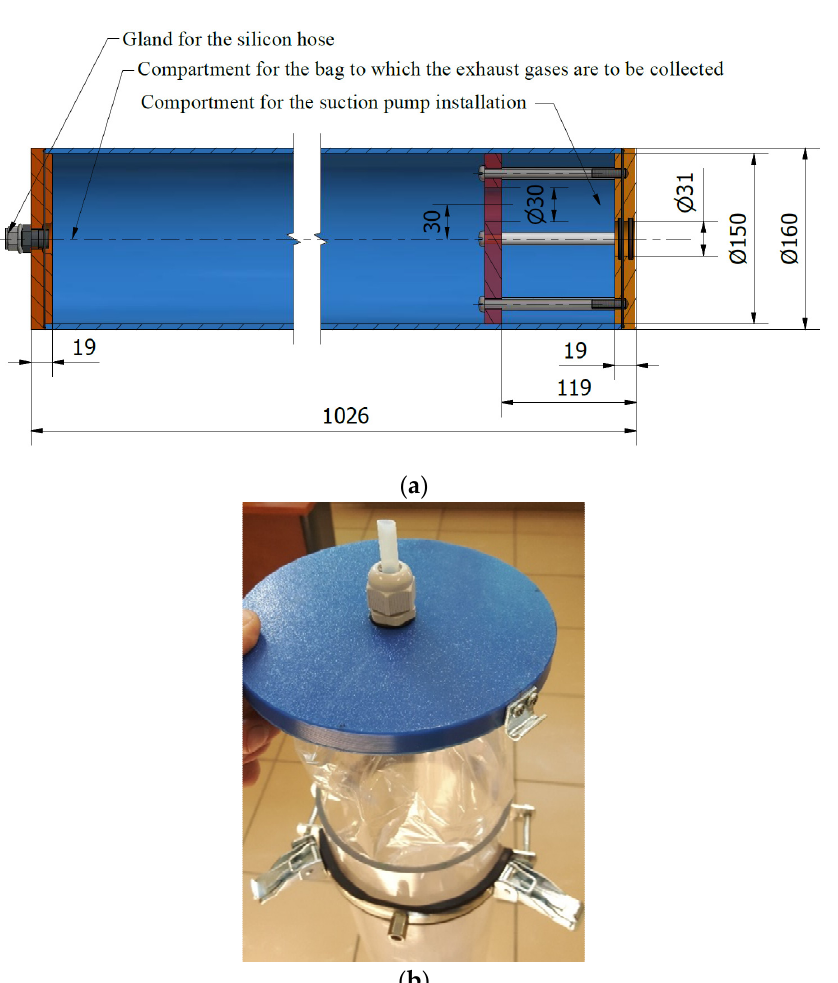
Figure 3. Exhaust gas collection and storage system: ( a ) technical diagram; ( b ) illustrative photo- graph.